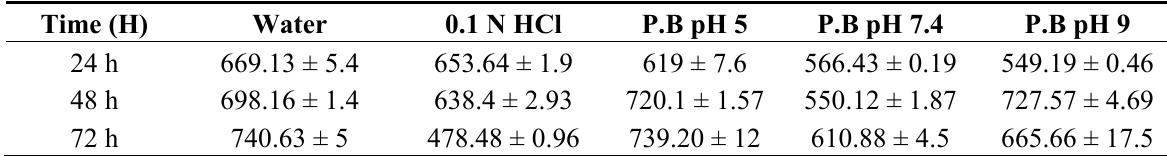
Table 2. Summary of the solubility study results, the values represent the concentration of TQ ± SD in μ g/mL, H (hours), P.B (phosphate buffer).